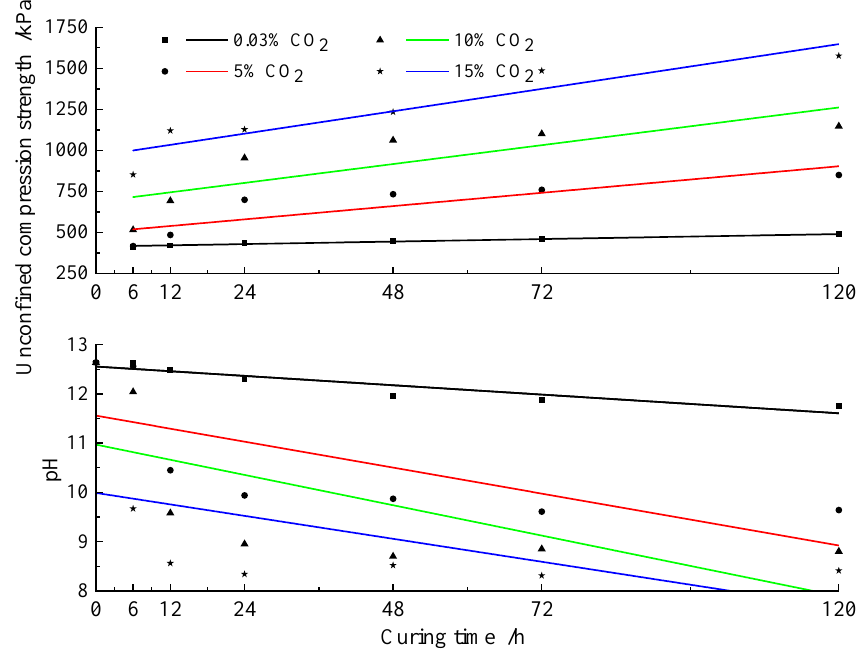
Figure 8. Relationship between pH value, unconfined compressive strength, and curing time.